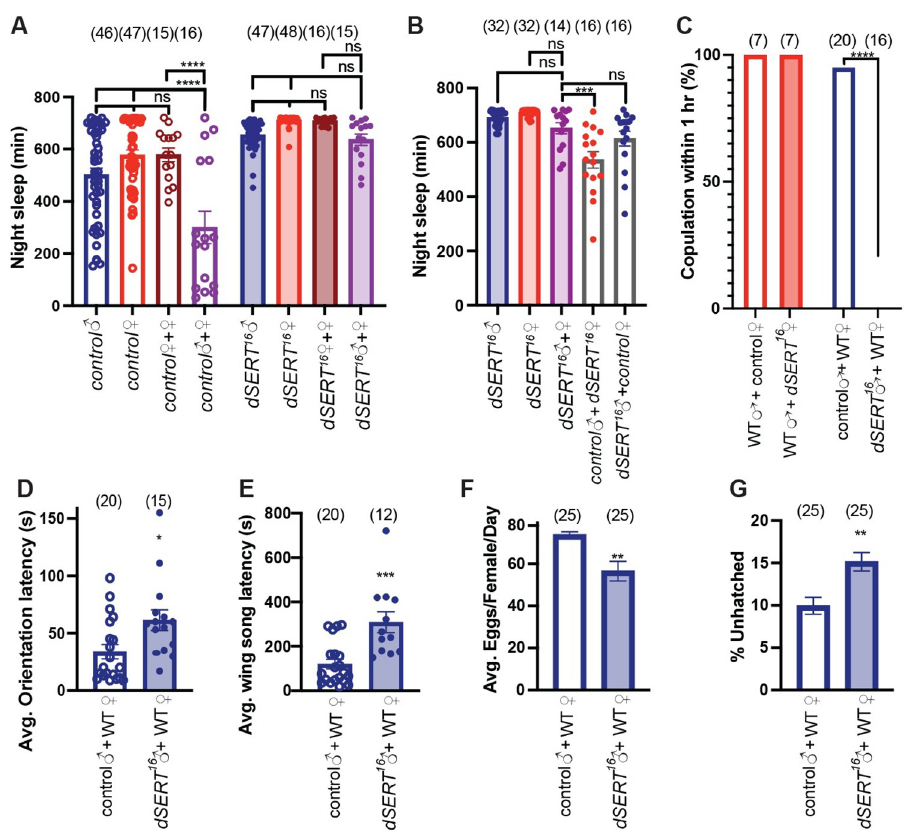
Fig 5. dSERT 16 mutants exhibit defects in courtship and copulation. (A) Quantification of nighttime sleep for males (blue) and females (red) individually housed in DAMs tubes for both control w 1118 (open bars/circles) and dSERT 16 (shaded bars/circles). Following 2 days of individual housing, male-female (purple) or female-female (dark red/ burgundy) were paired together in DAMs tubes and nighttime sleep was quantified for both w 1118 (open bar/circles) and dSERT 16 (shaded bar/circles). (B) Quantification of nighttime sleep for dSERT 16 males (shaded blue) and females (shaded red) individually housed or in male-female pairs (shaded purple) and for mixed co-housing of control males with dSERT 16 females (open grey bar with red circles) or dSERT 16 males with control females (open grey bar with blue circles). (C-G) Mating pairs made up of either wildtype (WT, Canton-S) males (red) or WT females (blue) with w 1118 controls (open bars) or dSERT 16 mutants (shaded bars). (C) Percentage of pairs that copulated within 1 hr. Quantification of average latency to orientation (D), and wing song (E). Quantification of egg laying (F) and percentage of eggs that failed to hatch 24 hours after being laid (G). All graphs (except C) show means ± SEM. A-B: one-way ANOVA, with Tukey post-hoc test (p � 0.0002 ��� , p � 0.0001 ���� ); C, Fisher’s exact test (P ���� � 0.0001); D-G, two-tailed unpaired t test (p � 0.0332 � , p � 0.0021 �� , p � 0.0002 ���